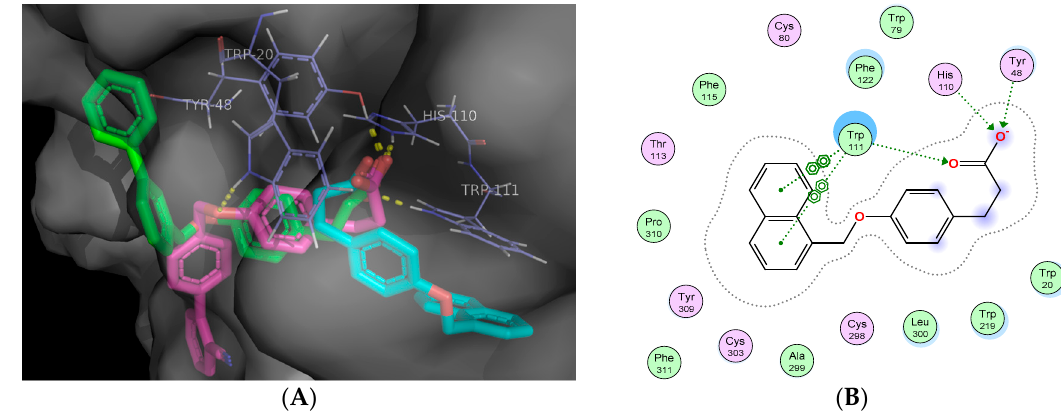
Figure 5. ( A ) 3D binding model of compounds 1 – 3 into the active site of Aldose reductase (AKR1B1). Compounds are presented as stick models: 1 (green), 2 (cyan) and 3 (magenta); ( B ) 2D interaction map of the second most active compound 2 and AKR1B1 .